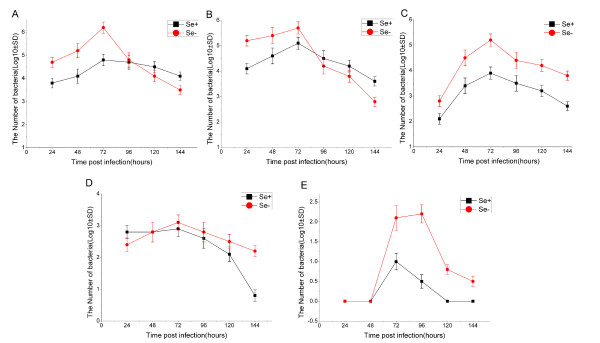
Survival and growth of L. monocytogenes in organs of Se-adequate or Se-deficient C57BL/6 mice. Survival and growth of L. monocytogenes in the intestine (A), lymph nodes (B), liver (C), spleen (D) and brain (E) of Se-adequate (Se+) and Se-deficient (Se-) inoculated orally with 5 × 109 CFU bacteria. Bacterial growth was followed in the organs at 24, 48, 72, 96,120 and 144 h post infection. Results are expressed as the mean concentration per group ± standard deviation (SD). *p < 0.05, **p < 0.01.